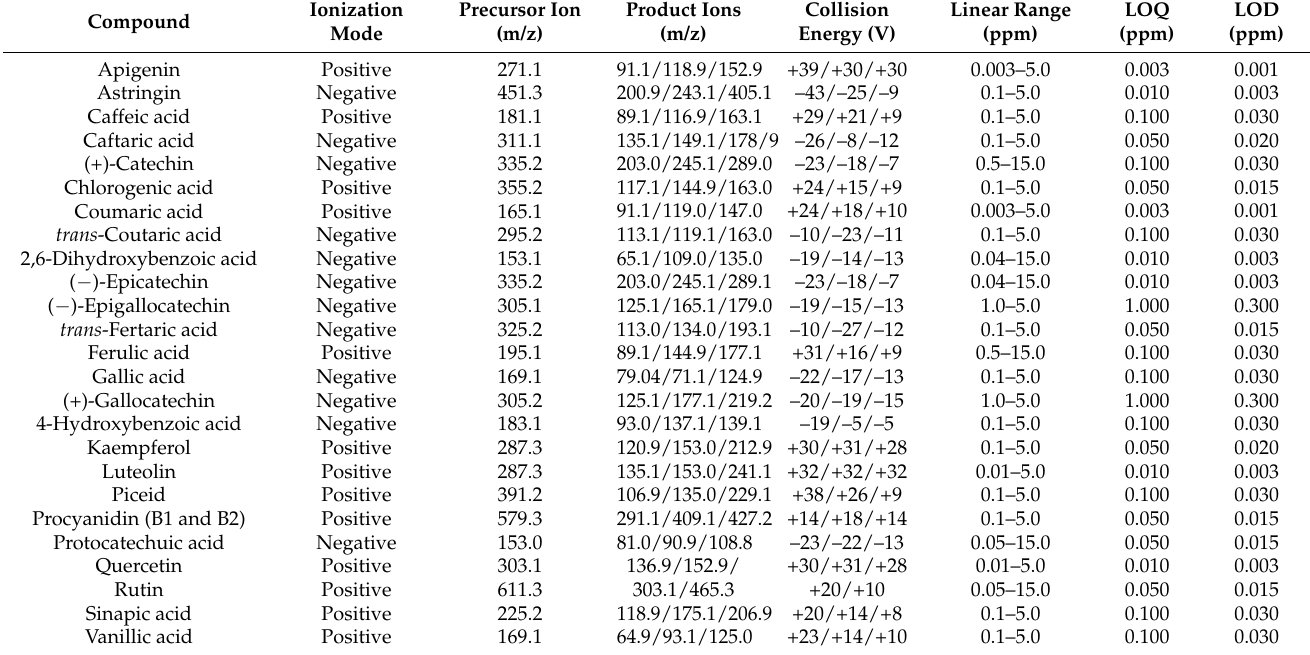
Table 1. Characteristic transitions monitored for the targeted (poly)phenols and their limit of quan- tification (LOQ), limit of detection (LOD), and range of